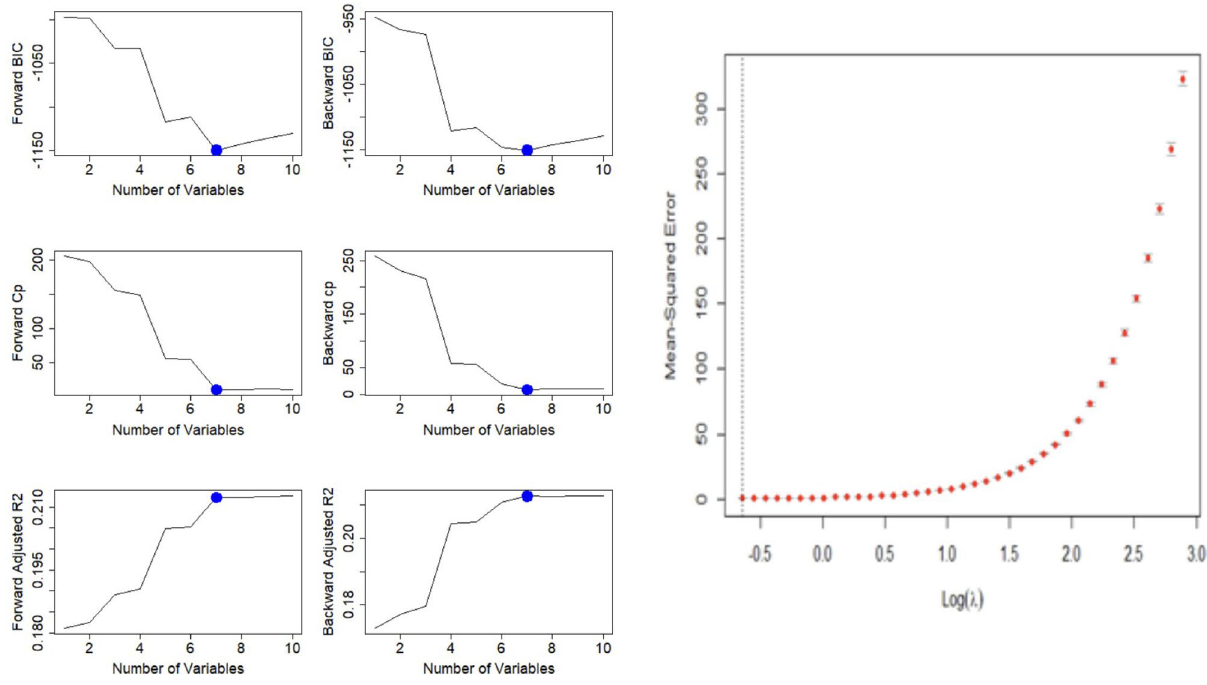
Figure 9. Boxplots between significant features.